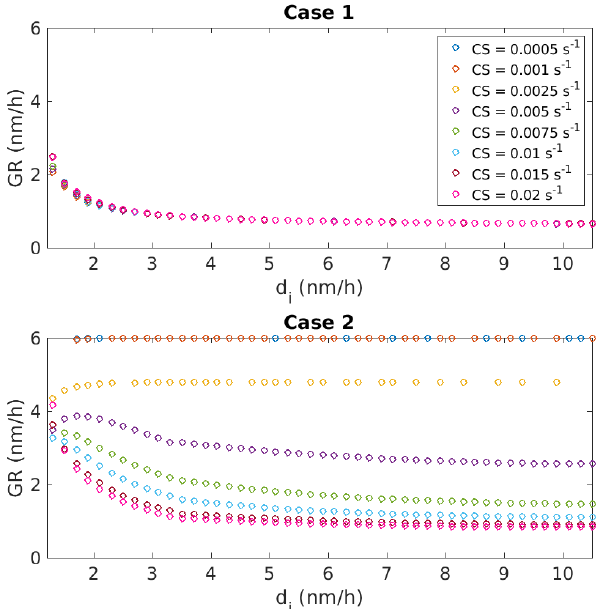
Figure 1. Appearance time method-based growth rates (GRs) for ACDC simulations with constant monomer concentration C mon = 10 7 cm − 3 as a function of the cluster diameter d i . GRs were deter- mined based on polynomial regression. Case 1 includes no cluster– cluster collisions, while in Case 2 cluster–cluster collision were al- lowed to occur. Different model runs had different input background condensation sinks (CS) and these have been marked with the dif- ferent